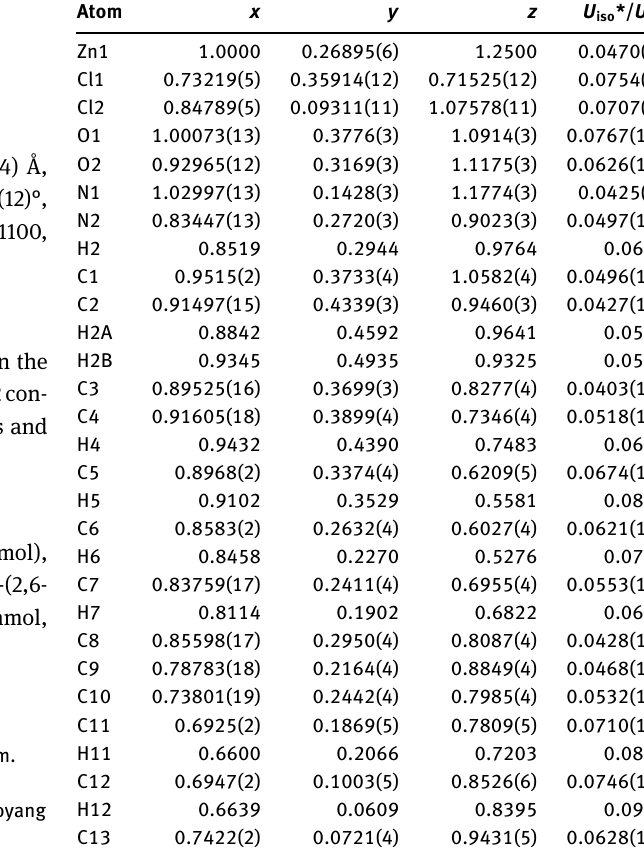
Table 2: Fractional atomic coordinates and isotropic or equivalent isotropic displacement parameters (Å 2